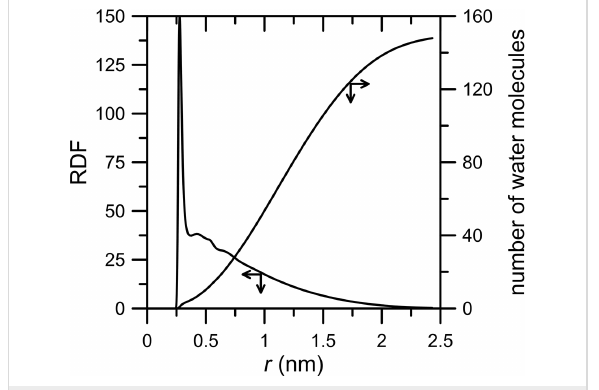
Figure 9: Radial distribution function of O w –O w pairs and the cumula- tive number of water molecules for the NN membrane system and CH 4 + N 2 gaseous mixture containing 200 water molecules.